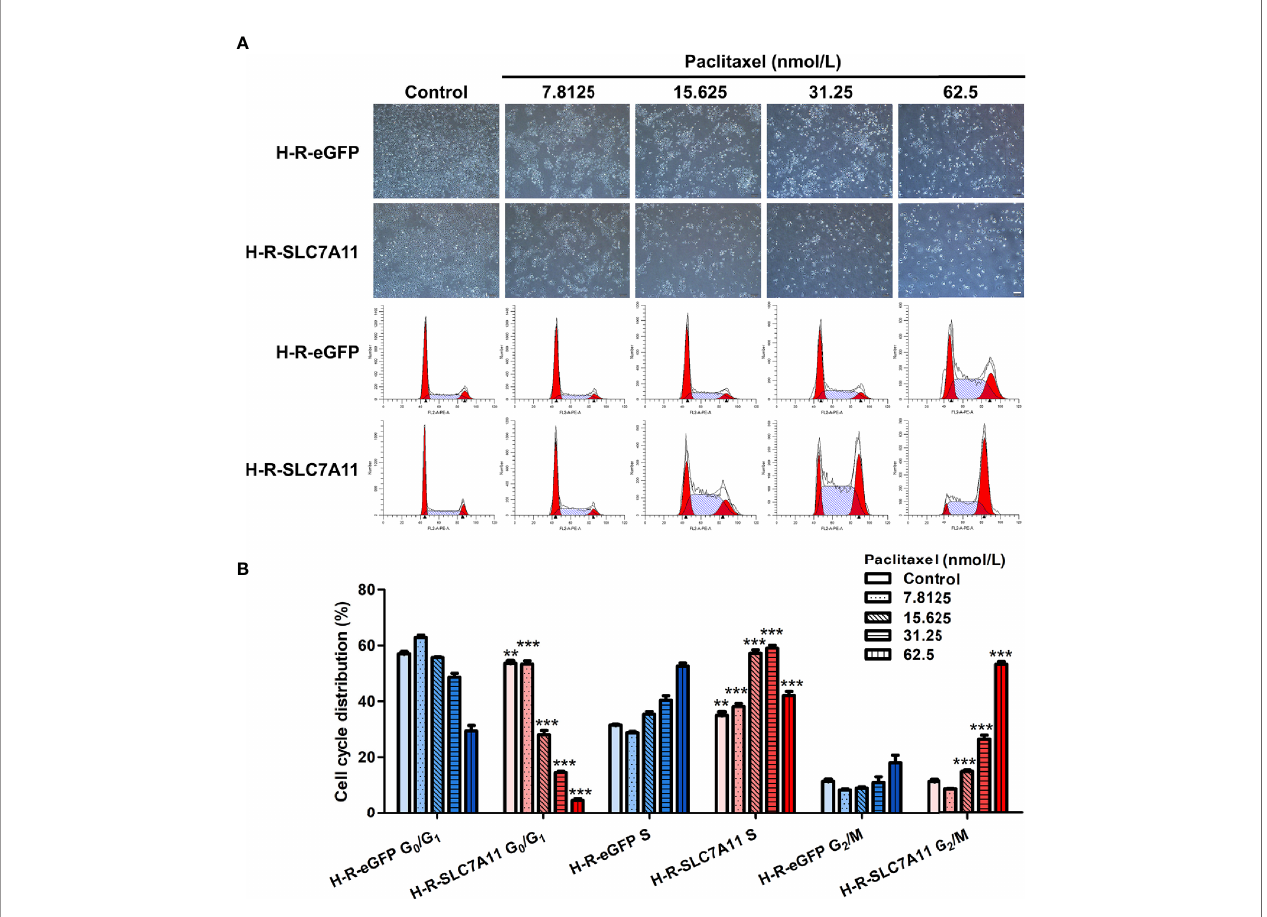
FIGURE 6 | Effects of paclitaxel on the cell cycle distribution of H-R-eGFP and H-R-SLC7A11 by PI staining and the fl ow cytometry analysis. (A) Representative cell- culture photos and cell-cycle images for H-R-eGFP and H-R-SLC7A11 cells treated with gradient paclitaxel for 72 h; (B) The percentage of cells in G0/G1 phase, S phase and G2/M phase of H-R-eGFP and H-R-SLC7A11 cells treated with gradient concentrations of paclitaxel for 72 hours. The statistical analysis in the fi gure was a pair-wise comparison between H-R-eGFP and H-R-SLC7A11 cells data with the same paclitaxel concentration and the same cell-cycle stage (** P < 0.01, *** P <